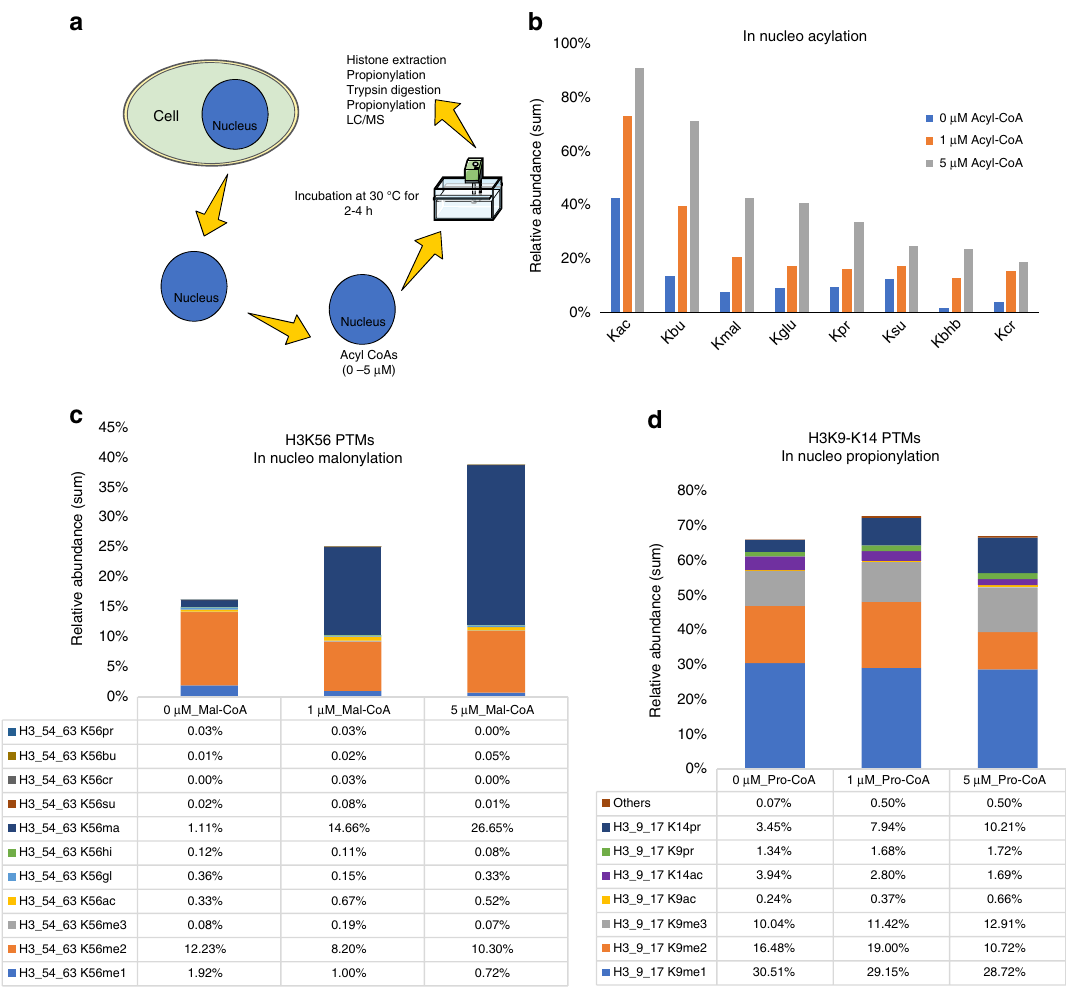
Fig. 5 Analysis of in nucleo acylation. a Schematic representation of in nucleo acylation assay. b Bar plots showing the dose-dependent acylation of histones upon treatment with 0, 1 and 5 μ M of acetyl-, butyryl-, malonyl-, glutaryl-, propionyl-, succinyl-, β -hydroxybutyryl and crotonyl-CoA, respectively. Values represent the sum of the relative abundances of all acylated peptides from histones H3 and H4. c Example of in nucleo acylation resulting in an increase in malonylation of H3K56 after treatment with increasing concentrations of malonyl-CoA. d Example of in nucleo acylation showing that induced propionylation by increasing the concentration of propionyl-CoA resulted into a reduced relative abundance of acetylation on the site